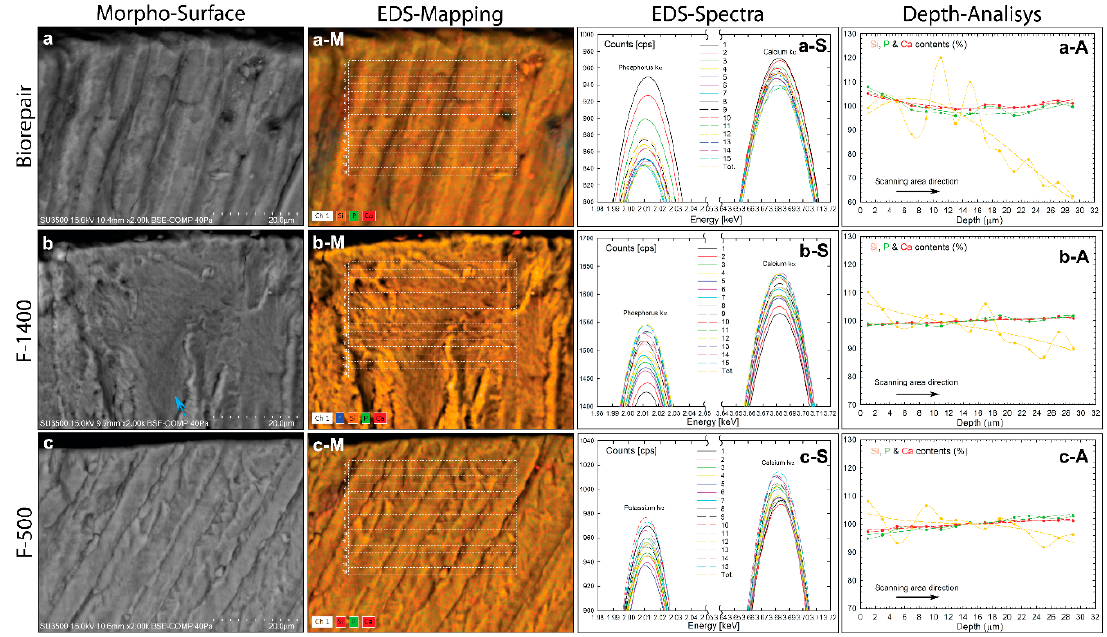
Figure 3. Morpho-chemical analysis of hydrated deciduous teeth brushed by Biorepair, F1400, and F500 biomaterial toothpastes. ( a – c ) VP-SEM images illustrating the surface morphology. ( a- , b- , and c-S ) EDS spectra probed on the corresponding biomaterials Figure 1d. ( a- , b- , and c-M ) multi- elemental mapping image of major constituents. ( a- , b- , and c-A ). Experimental plot showing atomic percentage distribution of Si, P, and Ca elements along the scanning area direction (dotted line) and data fitted by nonlinear regression for Biorepair and by linear regression for F1400 and F500 biomaterials (short dashed